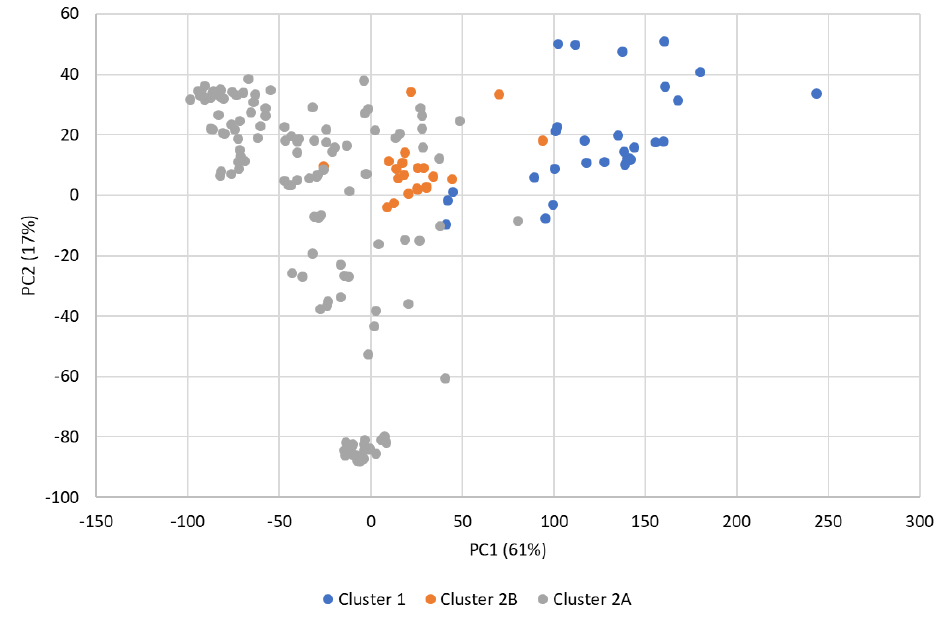
Figure 2. Graph of the scores of the first two principal components of the analysis of the marker data from the groundnut mini core collection.